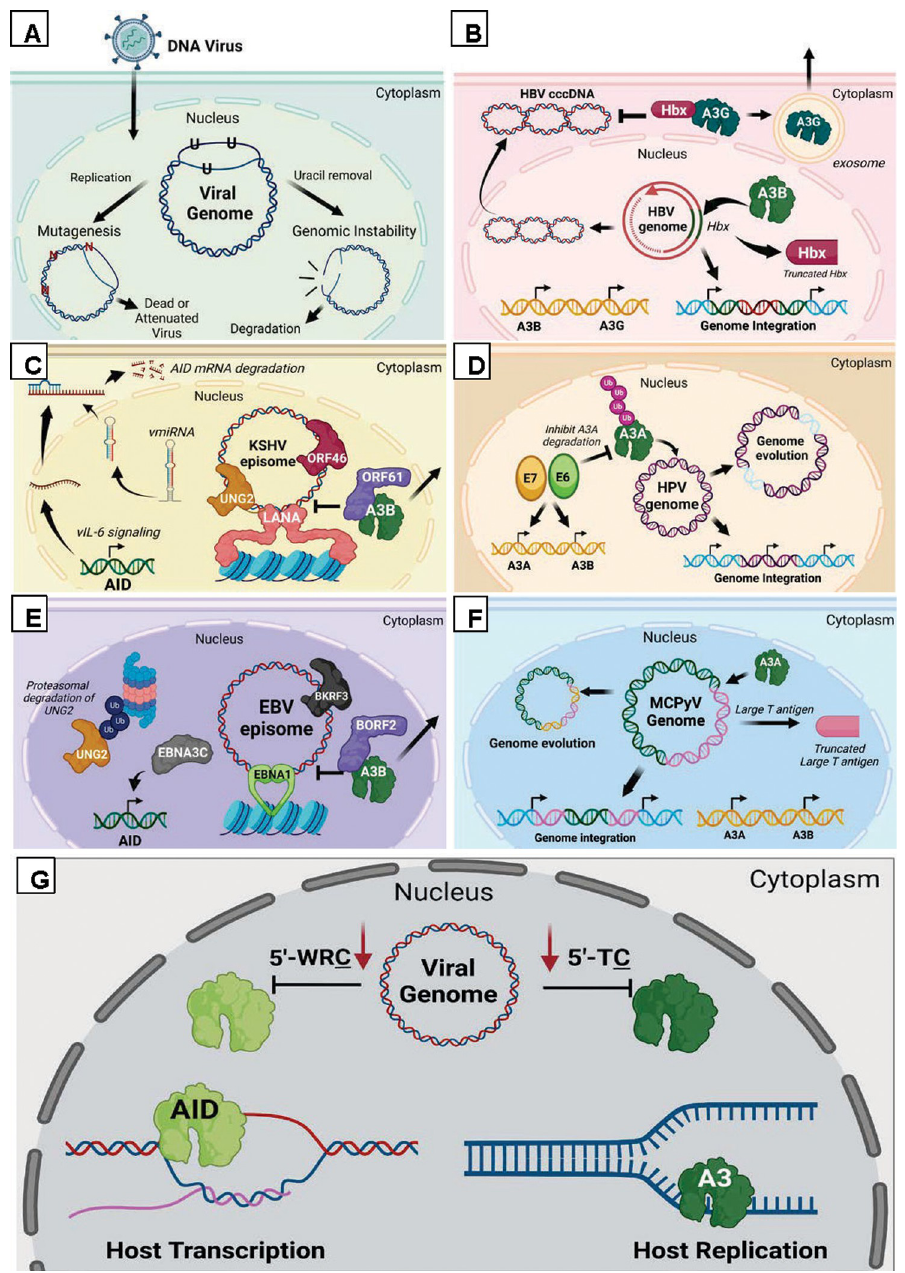
Fig 2. Overview of DNA tumor virus antagonism of uracil-mediated antiviral immunity (UMAI). (A) Representative schematic of successful UMAI by the AID/A3 proteins. Uracils introduced into the viral genome by the AID/A3 proteins are replicated or removed by UDG resulting in a dead or attenuated virus and viral restriction. (B) HBV’s viral protein Hbx antagonizes A3G targeting the viral cccDNA in the cytoplasm, by exosome export. Proposed A3B editing of the Hbx gene results in the carcinogenic truncated mutant and possibly genome integration. (C) KSHV vIL-6 up-regulates AID but antagonizes UMAI through viral miRNA targeting AID transcripts for degradation. KSHV also avoids UMAI by changing nuclear A3’s cellular localization via its vRNR protein (ORF61). The KSHV episome may be protected from uracil accumulation during latency because it encodes for its own vUNG (ORF46) or through the tethering of the host UNG2 via LANA. (D) HPV’s oncogenic proteins E6 and E7 keep A3 expression on and inhibit degradation of A3A. It has been proposed that A3 targeting of the HPV genome leads to genome integration and viral evolution, including depletion of 5’ TC dinucleotides. (E) EBV’s EBNA3C protein up-regulates AID but may avoid uracil genotoxicity by degradation of the host UNG2 and utilizing its own vUNG protein (BKRF3). Like KSHV, EBV’s vRNR (BORF2) relocalizes nuclear A3 proteins to alternative cellular compartments. (F) MCPyV, like HPV, may